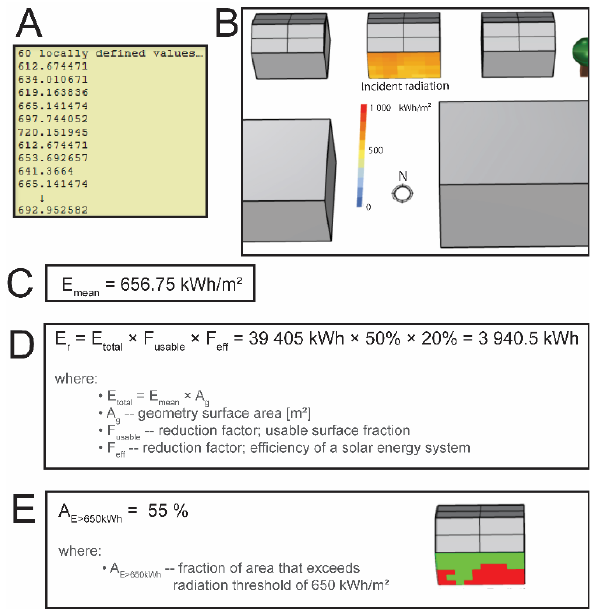
Figure 3. Example of creating different metrics from the same annual solar radiation simulation data. The model was drawn in Rhinoceros [27], and the simulation was performed with Ladybug 1.3.0 [28]. ( A ) list of values for every analysis grid point resulting from the annual solar radiation computation; ( B ) visual presentation of solar radiation metric; ( C ) radiation metric computed as an average; ( D ) radiation metric based on a formula; ( E ) normalised radiation metric based on thresh ‐ old compliance.